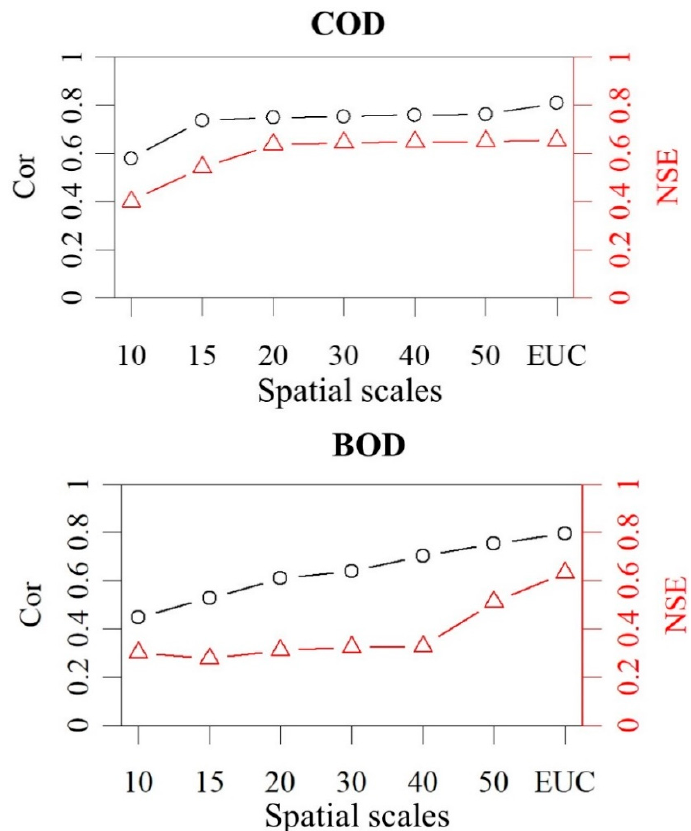
Figure 4. The evaluations of Bayesian networks (BNs) in seven spatial scales by Pearson’s correlation coefficients (Cor) and Nash–Sutcliffe efficiency coefficients (NSE). The black and red lines are Cor and NSE, respectively.